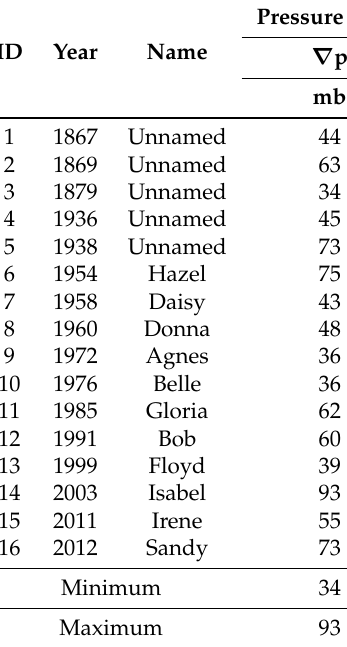
Table 2. Major historical hurricane characteristics impacting area of interest.